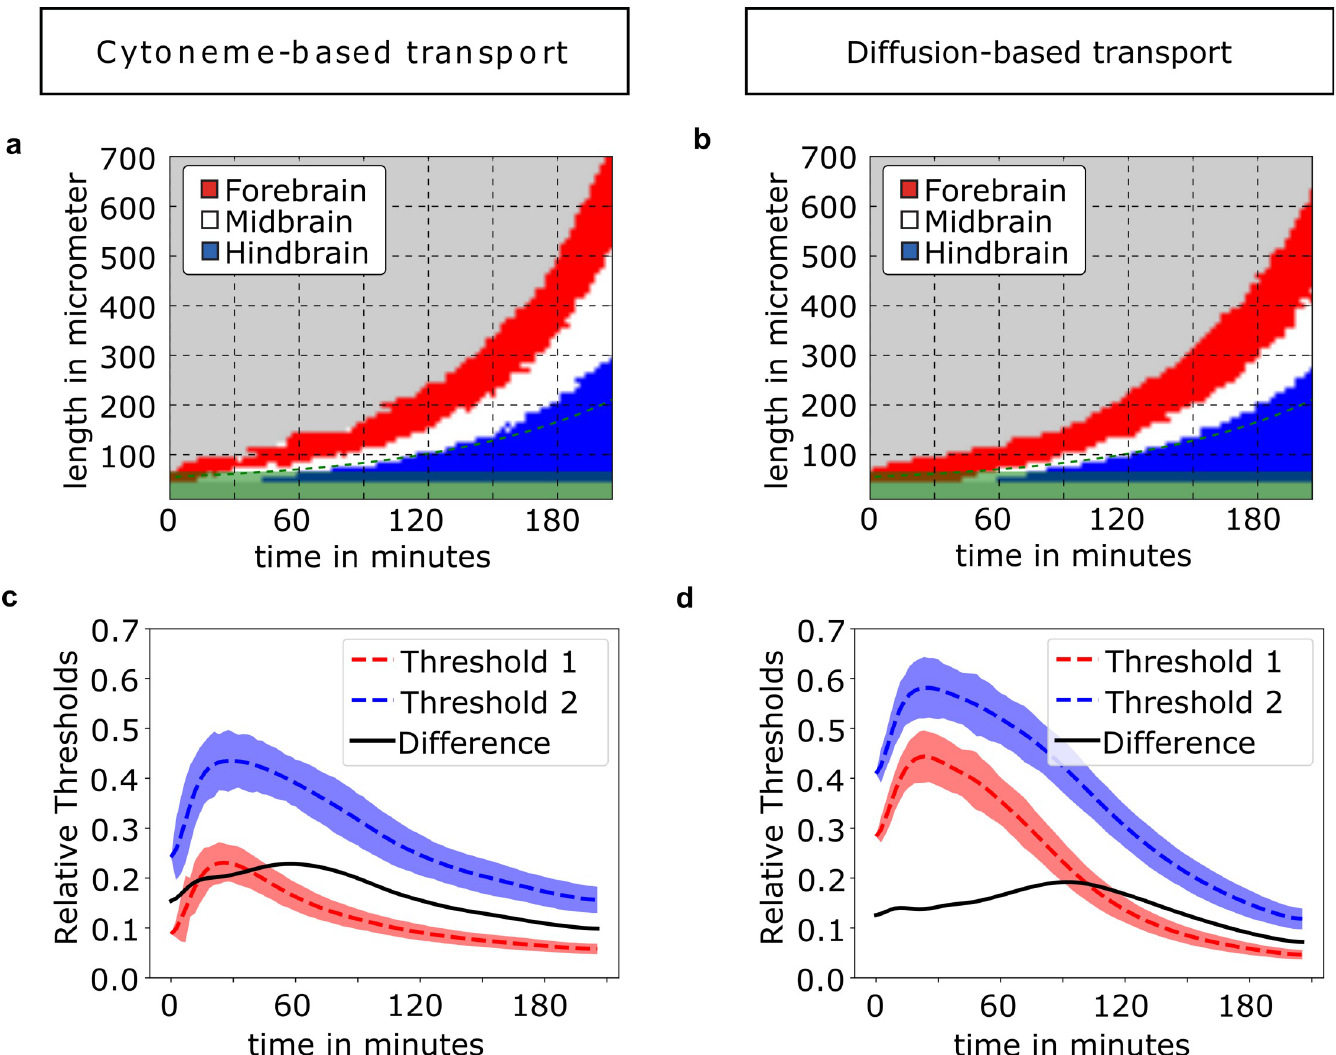
Fig 5. Timing of the pre-patterning for cytoneme-based and diffusion-based transport. In a) and b) the development of the pattern boundaries between brain areas during the tissue growth is shown. Colors indicate the respective brain primordium. The thresholds are set to split the tissue into thirds by number at t TRS = 90 min. The green area indicates the layers of the morphogen producing cells. c) and d) show the thresholds for splitting the total number of cells into thirds at each respective point in time. The dashed lines are the averages of 100 simulations with the transparent regions showing the standard deviation σ . The lower threshold (red dashed line) separates forebrain and midbrain, the upper threshold (blue dashed line) separates midbrain and hindbrain. The difference between both thresholds (black line) indicates the distinctness between the thresholds separating cell fates.